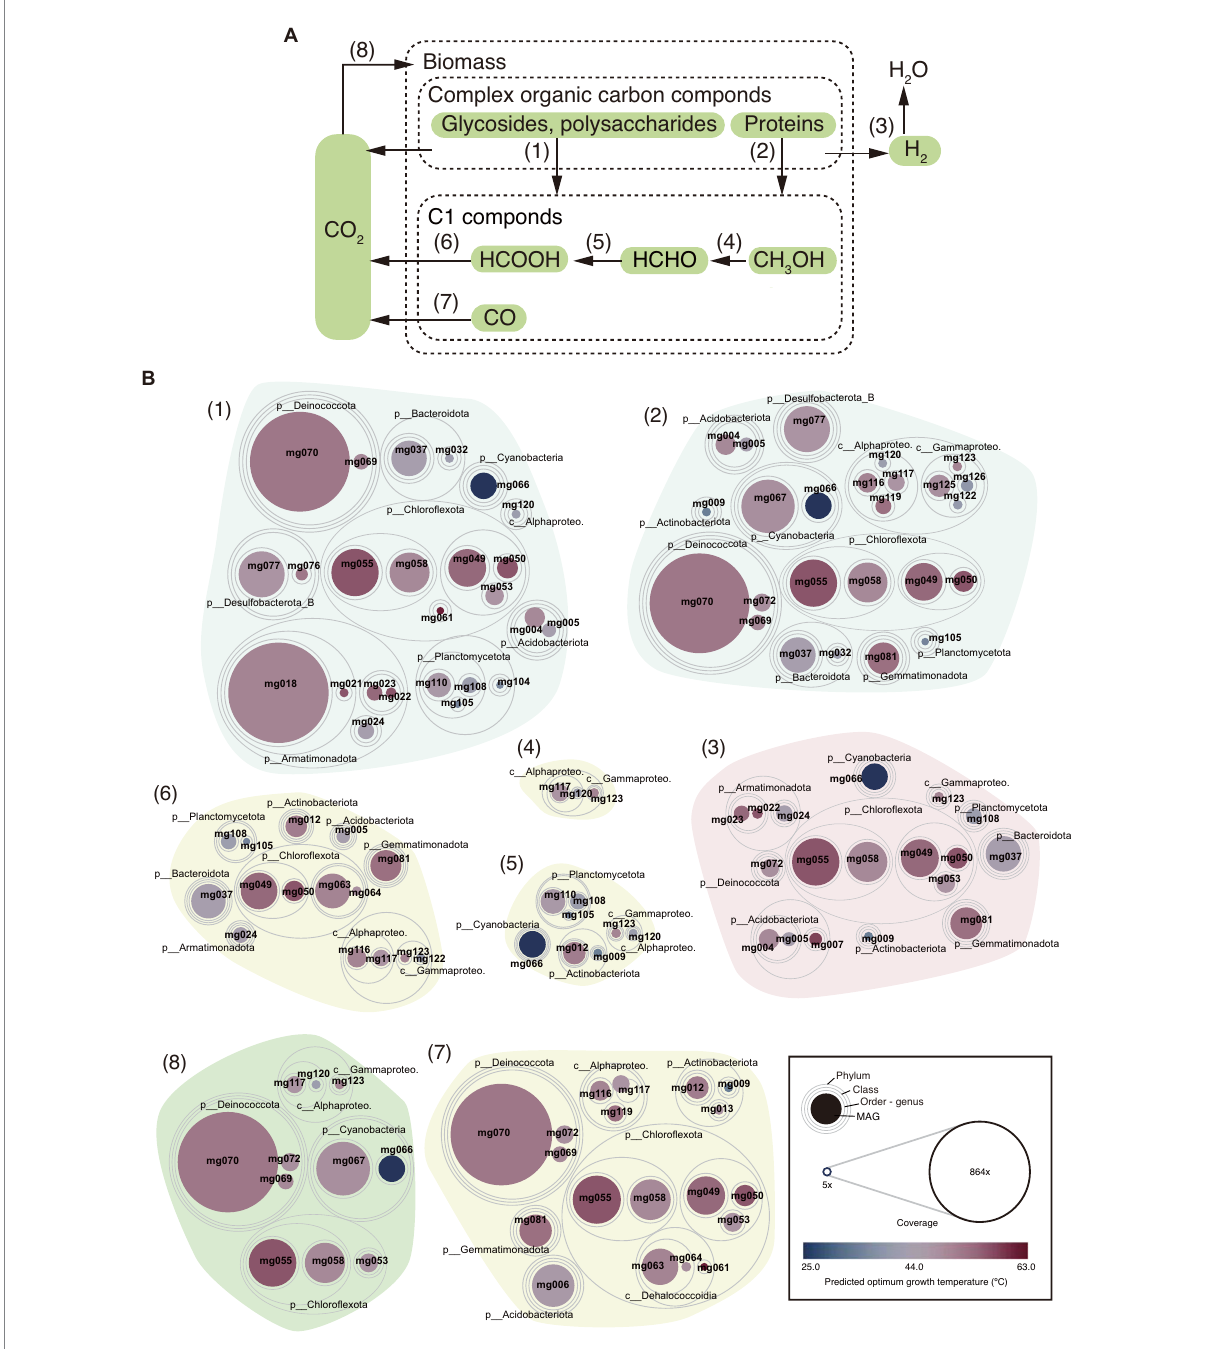
FIGURE 3 MAG-based model of carbon cycle. (A) Outline of carbon cycle and (B) the 61 HQ MAGs derived from prokaryotes potentially involved in each step (indicated by the numbers in